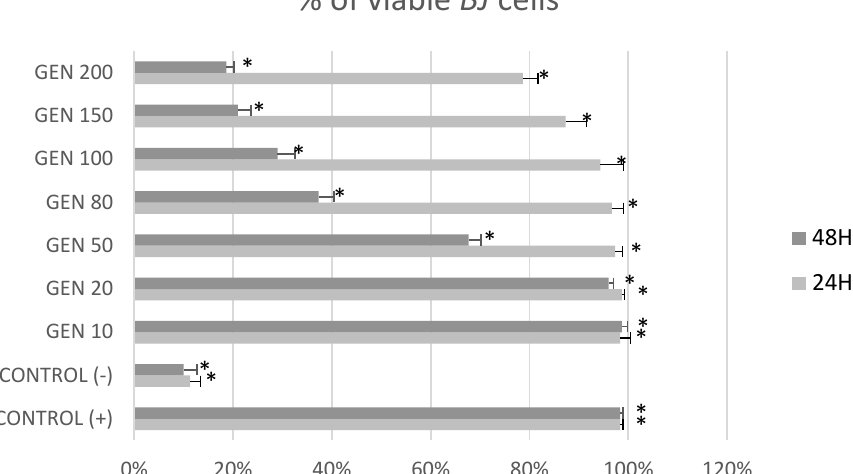
Figure 6. Percentage of viable BJ cells [%] in trypan blue exclusion assay after treatment with genistein at different concentration [ µ M]. Results are the mean ± SD of n = 3. * Statistically significant ( p < 0.05; ANOVA followed by Dunnett’s test compared with control group). Cells cultured with 0.1% DMSO were considered Control (+). Cells cultured with 15% DMSO were considered Control ( − ).